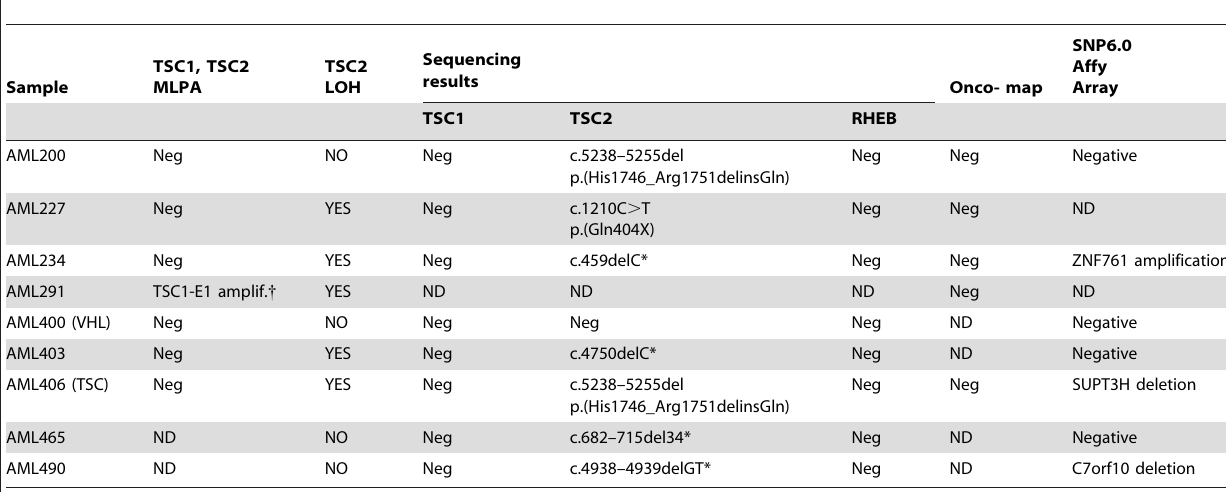
Table 2. Summary of genetic findings in AML